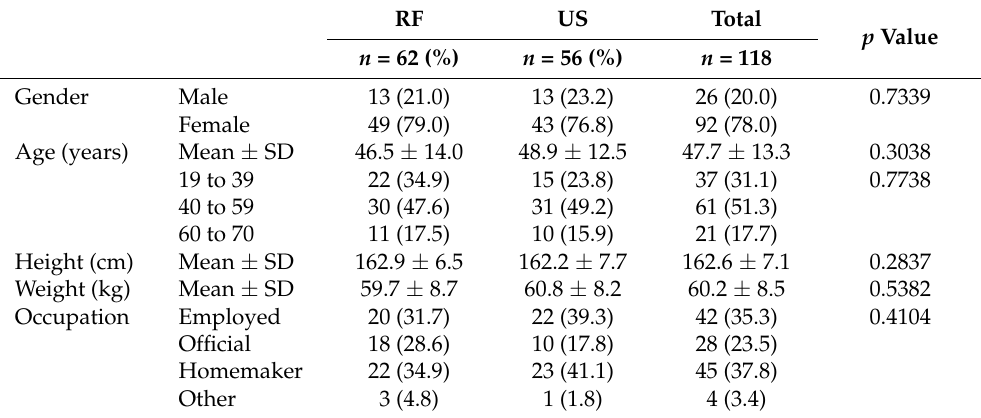
Data are mean ± SD or n (%) values. RF, radiofrequency group; US, ultrasound group; SD, standard deviation. Chi-square with Fisher’s exact test was used to compare gender, age distribution, occupation. Independent t -tests were performed to identify differences in age, height,